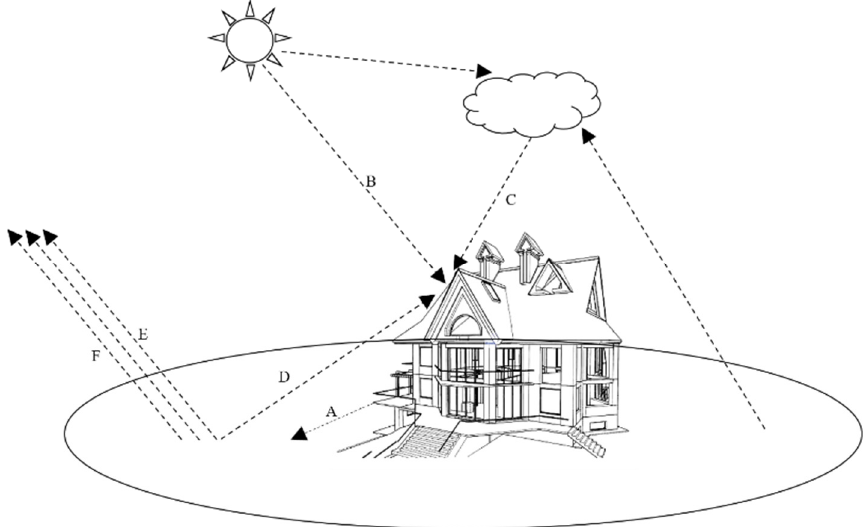
Figure 1. A 3D model of processes of energy interactions to reach thermal equilibrium under natural conditions: (A) heat transferred by temperature differences between objects; (B) energy directly transmitted to objects by solar radiation; (C) energy transferred by particles to objects after absorbing external radiation; (D) heat radiation energy transferred from surrounding objects to the target object; (E) energy transferred by fluid flow; and (F) energy transferred by water evaporation, water vapor condensation and migration.